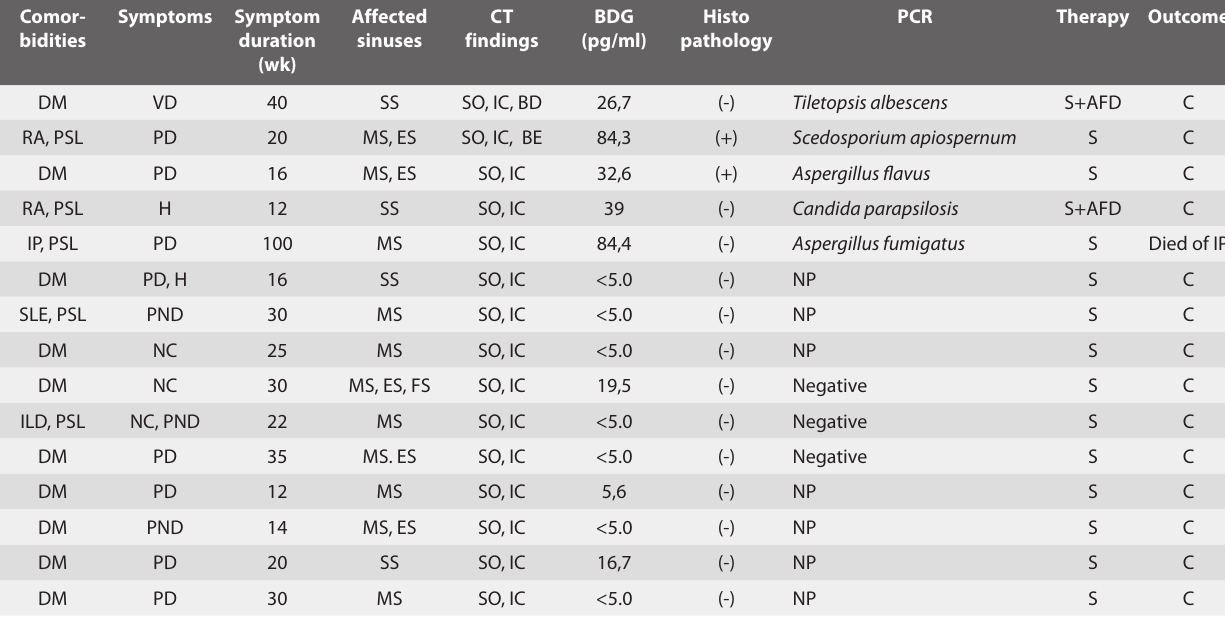
Table 1. Clinical features, mucosal histopathology, laboratory data, therapy, and outcome in fungal rhinosinusitis patients. Comor-